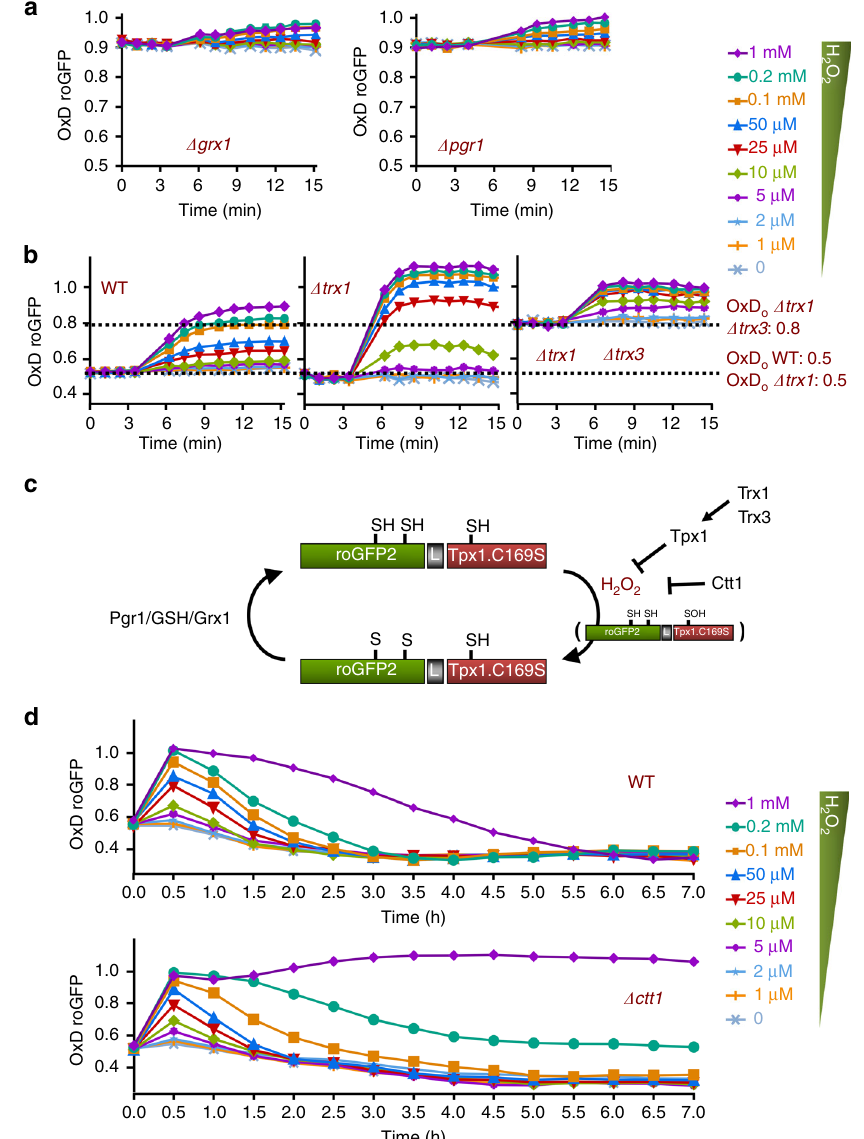
Fig. 4 Effect of genetic mutations on roGFP2-Tpx1.C169S oxidation. Strains SB36 ( Δ grx1 ) and AD88 ( Δ pgr1 ) ( a ) and strains HM123 (WT), SG61 ( Δ trx1 ), and IC76 ( Δ trx1 Δ trx3 ) ( b ) were transformed with plasmid p407.C169S and H 2 O 2 treatments were performed and oxidation of the reporter estimated as described in Fig. 1. c Scheme depicting the role of cellular electron donors in roGFP2-Tpx1.C169S probe oxidation and reduction. Blockage of H 2 O 2 detoxi fi cation either by lack of Tpx1 recycling or by lack of Ctt1 activity results in accumulation of basal or H 2 O 2 -induced oxidized roGFP2.C169S. Recycling of roGFP2.C169S depends on Grx1 at the expense of GSH and Pgr1. d Strains HM123 (WT) and EP160 ( Δ ctt1 ) were transformed with plasmid p407.C169S and H 2 O 2 treatments were performed and oxidation of the reporter estimated as described in Fig. 1. For each panel, data from three biological replicates are shown, with error bars (S.D.) displayed in Supplementary Fig.